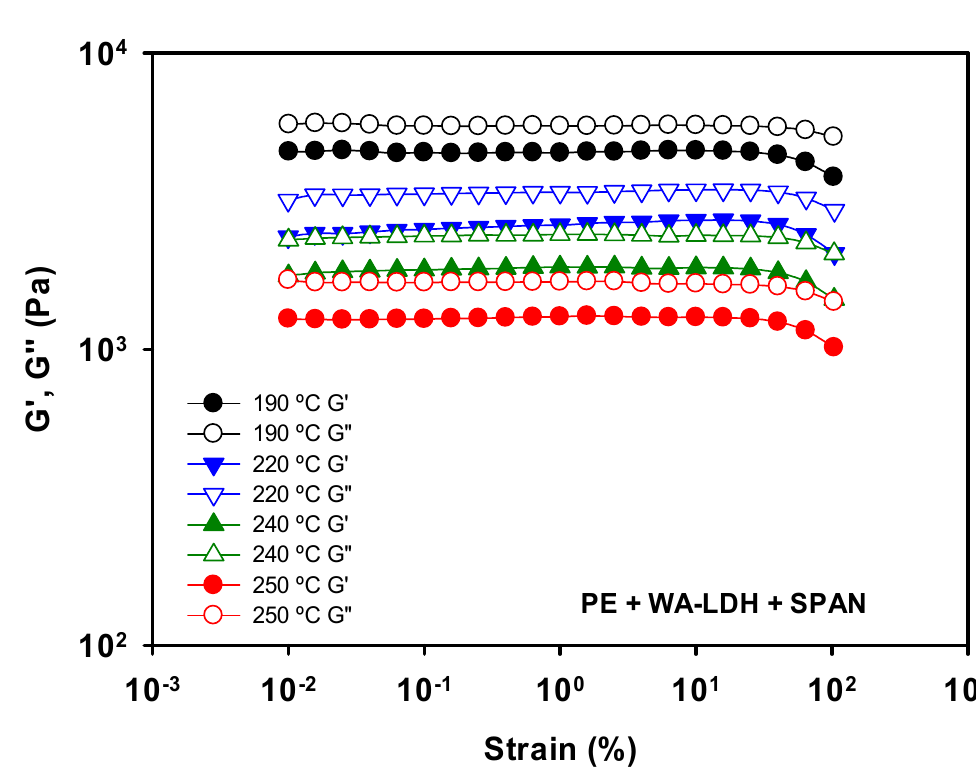
Figure A2. Elastic (G (cid:48) ) and Viscous (G”) moduli determined by amplitude sweeps of PE with modified Figure B. Elastic (G’) and Viscous (G’’) moduli determined by amplitude sweeps of PE with LDH with whitening agent and SPAN at 190, 220, 240, and 250 ◦ modified LDH with whitening agent and SPAN at 190, 220, 240, and 250 °C.